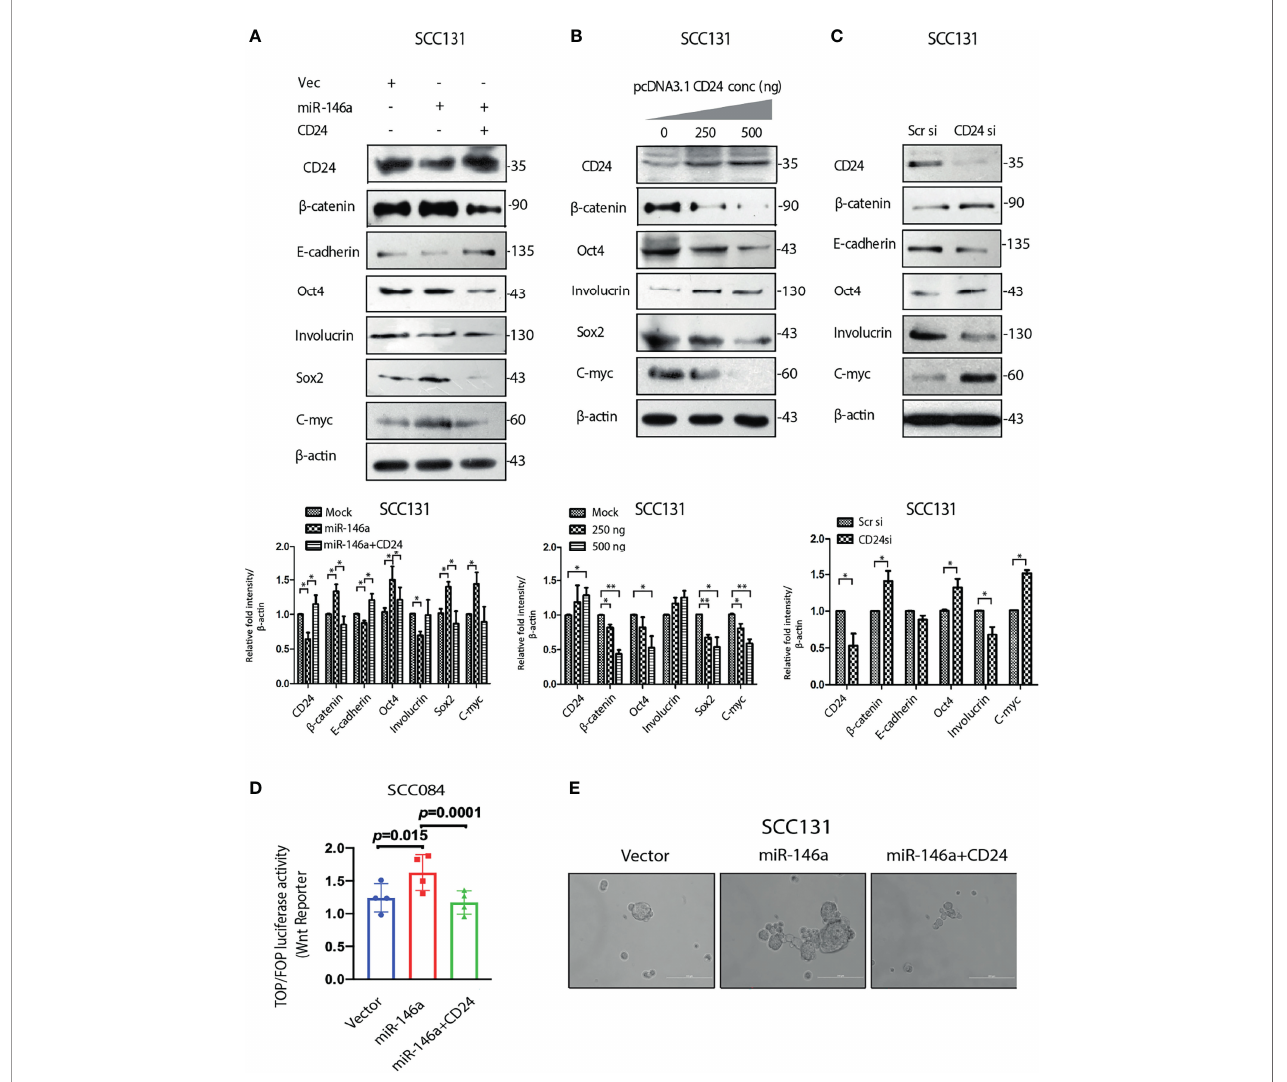
FIGURE 5 | MiR-146a promotes stemness by down-regulating CD24 (A) Immunoblot analysis of SCC131 transfected with either a vector control, miR-146a with or without CD24 showing rescued expression of b -catenin and E-cadherin as well as Involucrin Oct-4, Sox2, C-myc. (B) Immunoblotting of the same proteins with increasing dose of CD24 expression and (C) upon knockdown of CD24 in SCC131 cells. b -actin is loaded as an endogenous control. Histograms show fold changes in the densitometric values of band intensity and shown as means ± S.D. of 3 individual experiments. (D) Wnt reporter activity as measured by Top-Flash vs Fop-Flash luciferase construct in SCC084 mock, miR-146a with or without CD24 transfection, as indicated (p-value computed by one sample t-test). (E) Sphere formation ability under similar conditions as described in (D) (Scale bar = 200